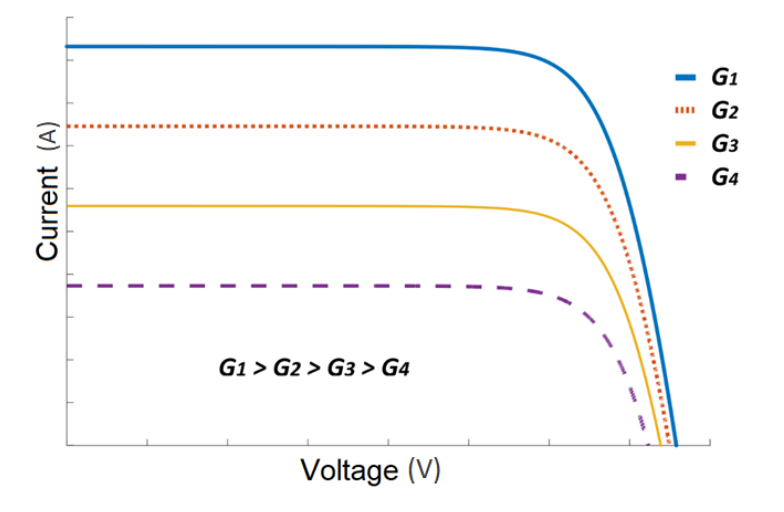
Figure 6. Effects of different levels of irradiance incident (G) on the surface of the PV cell on the I-V curve of the cell